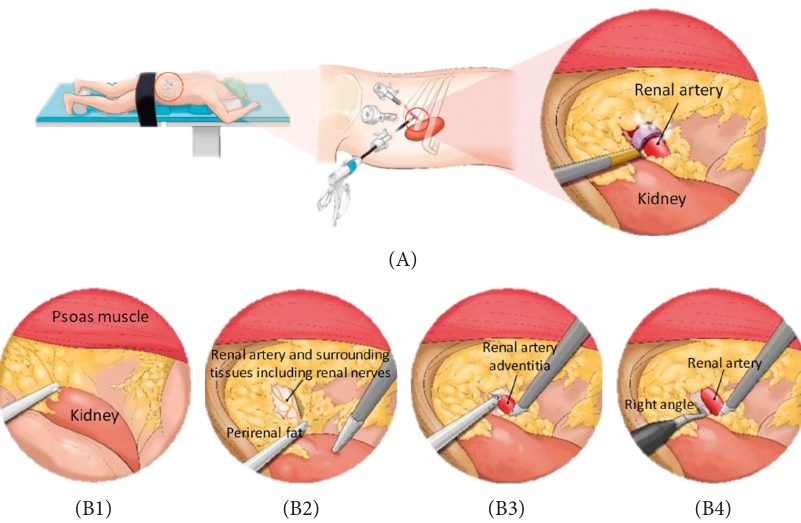
Figure 5: Flowchart of laparoscopic renal denervation. (a) Modified prone position for laparoscopic RDN. (b) Schematic to show the steps of laparoscopic RDN; (B1) dissection between psoas muscle and Gerota’s fascia; (B2) removal of fat tissues around the renal hilum and identification of connective tissues surrounding the renal artery including renal sympathetic nerves; (B3) removal of periarterial connective tissue using a laparoscopic monopolar hook electrode; (B4) securing space to insert the laparoscopic ablation instrument using right angle dissector. Reproduced from reference